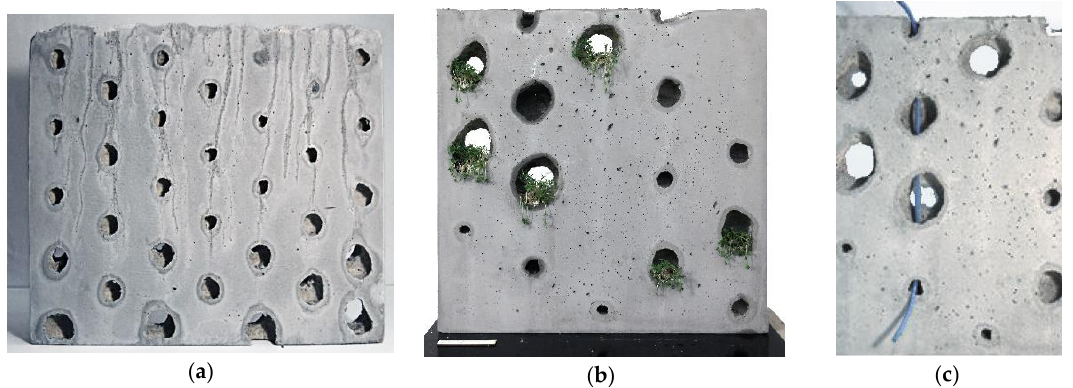
Figure 13. SiC demonstrators: ( a ) panel with displacement bodies gradually decreasing in size towards the top; ( b ) concept for façade planting; ( c ) integration of continuous channels connecting the voids for